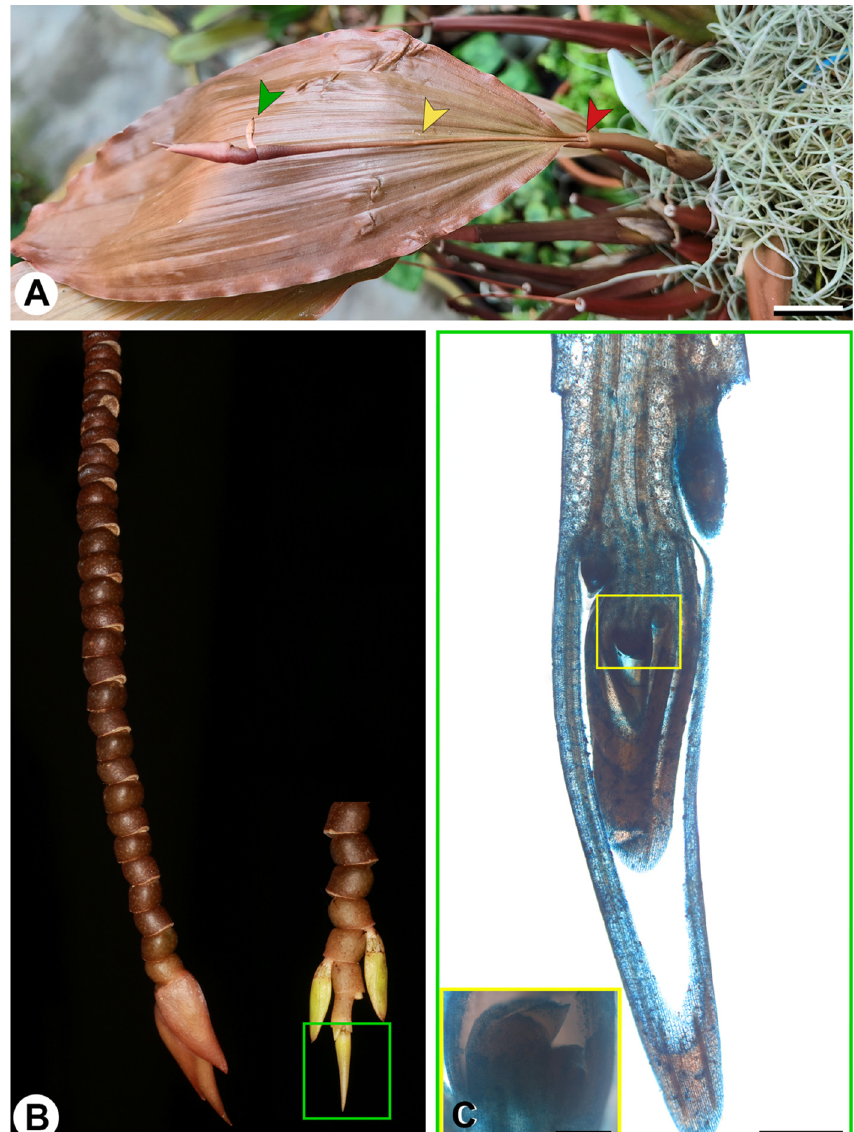
Figure 3. Inflorescence of C. monilirachis. ( A ) Stage of formation of the first floral unit, red arrow—stem section of the inflorescence (peduncle), yellow arrow—elongated first floral unit of the rachis, green arrow—resupinate apical flower of the first floral unit; ( B ) distal part of the rachis of a 5-year-old generative shoot; inset: morphological structure of the inflorescence tip without bracts and with non-resupinated flower buds; ( C ) longitudinal section of the inflorescence apex; inset—spherical meristem of apical flowers of two successive axes. Scale bars: ( A ) = 1 cm; ( B ) = 1 cm; ( C ) = 1 mm (inset = 0.2 mm).